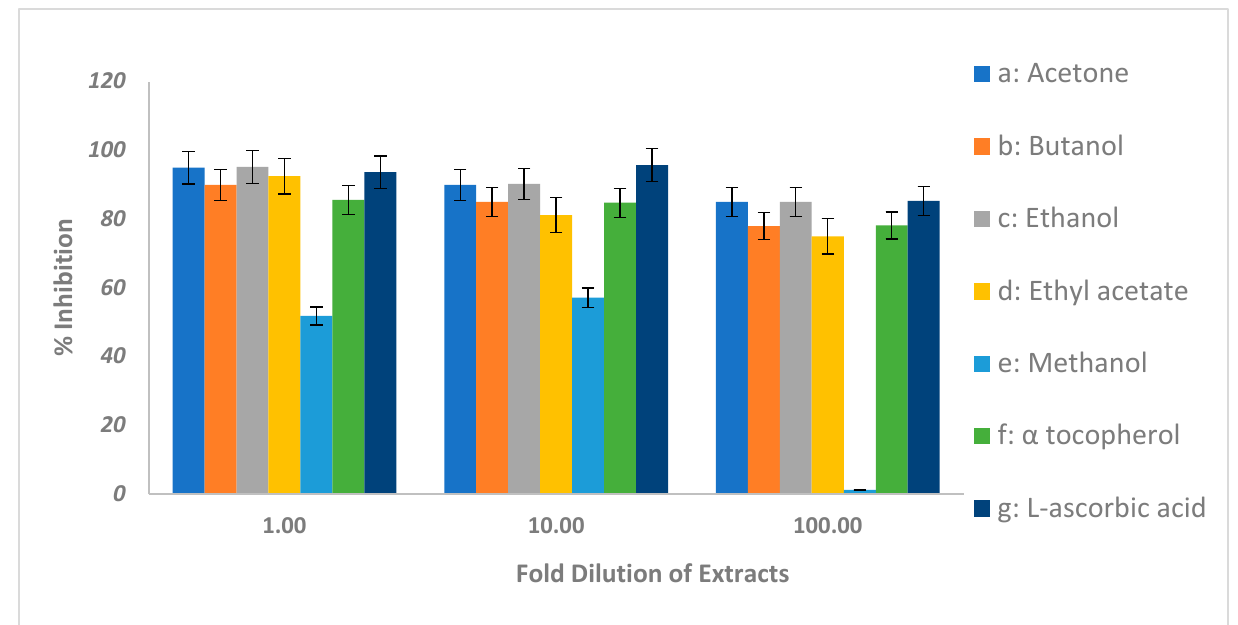
Figure 1. The antioxidant activity of the Acacia ehrenbergiana extracts by the DPPH method. Various extracts prepared from Acacia ehrenbergiana were subjected to the DPPH assay as described in the Materials and Methods section. The inhibition activity was compared to known antioxidants ( α‐tocopherol and ascorbic acid).